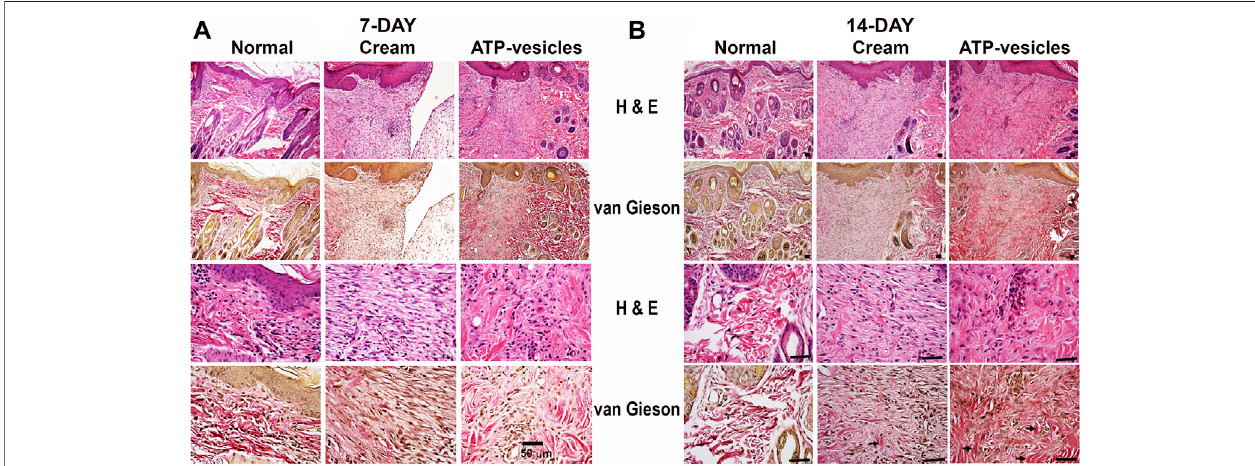
FIGURE 4 | Hematoxylin/eosin and Van Gieson staining of wound tissues on postoperative day 7 (A) and 14 (B) . The representative images show the wounds treated with ATP-vesicles have more intense collagen fi bers (red color) than the wounds treated with neutral cream. The collagen fi bers also exhibit a more organized pattern in ATP-vesicle-treated wounds on postoperative day 14. The arrows indicate positive staining of the collagen fi bers. Scale bar is 50 μ m.